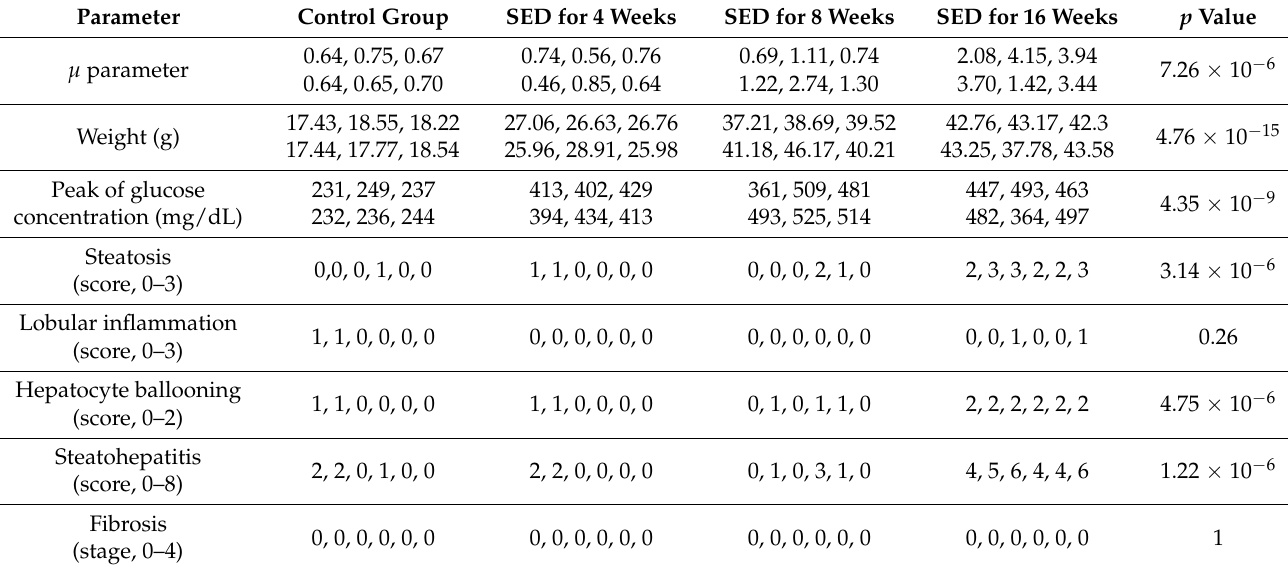
Table 1. Changes in steatosis, steatohepatitis, and fibrosis in the sedentary group (the normality test failed, and thus ANOVA on ranks was applied).